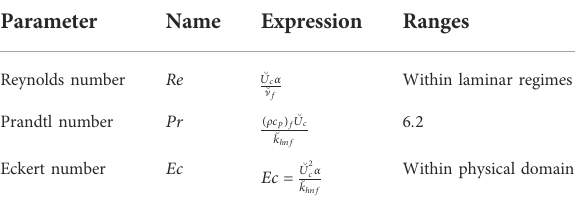
TABLE 6 Parameters ingrained in the model with expressions and physical